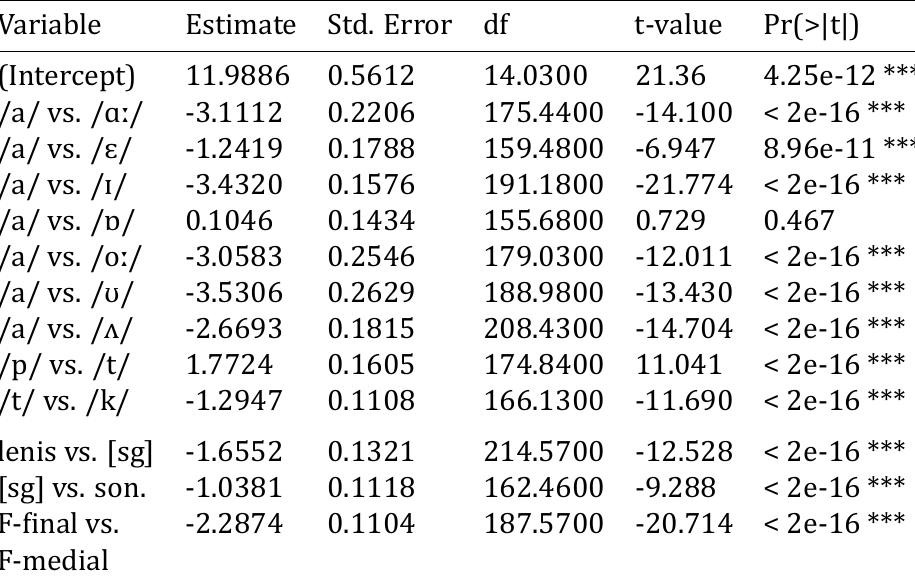
Table 3: Statistical results for pre-aspiration duration (normalised)